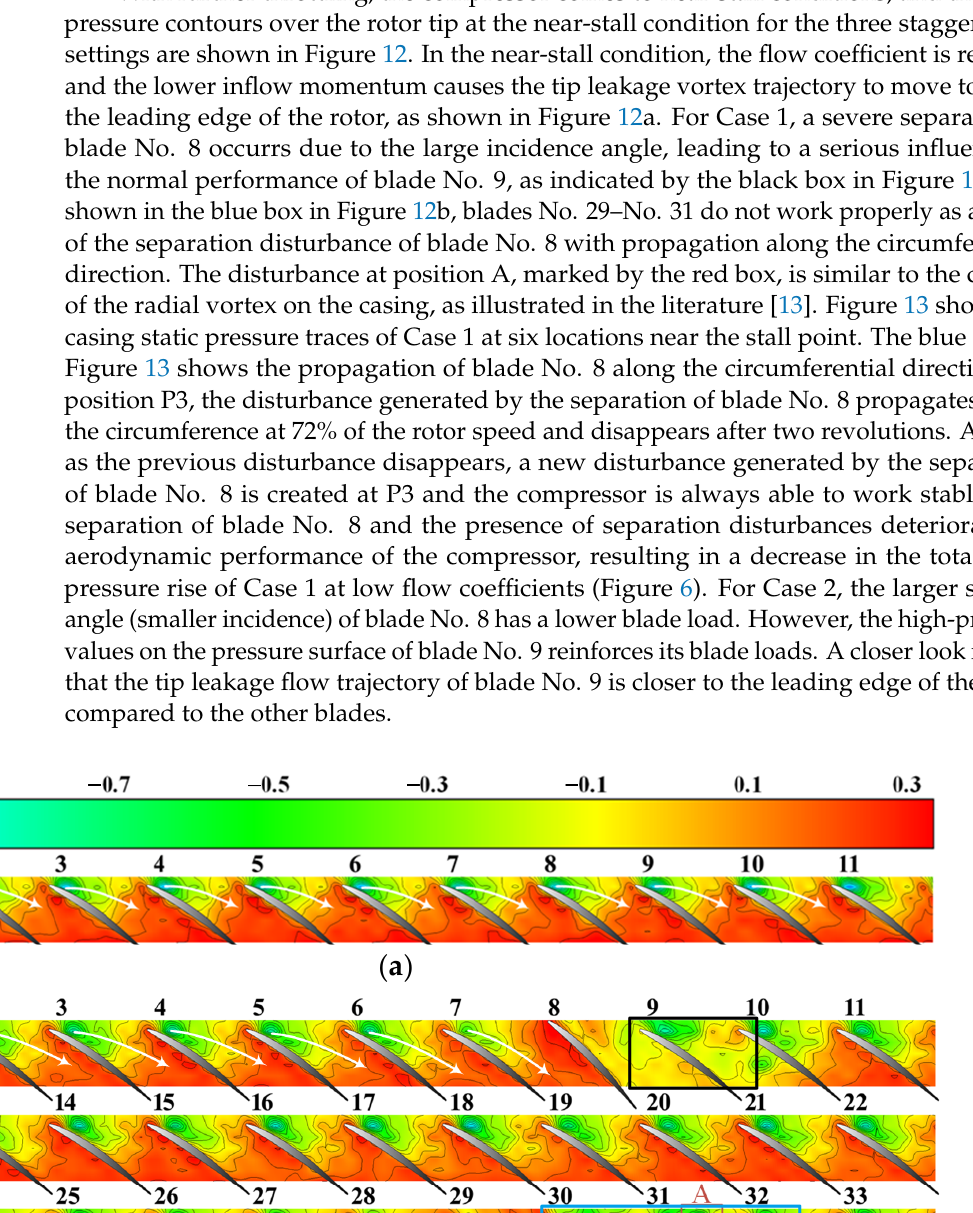
Figure 13. Casing static pressure trajectory of Case 1 at the near-stall point. Above all, the non-uniform distribution resulting from an increased or decreased lo- cal stagger angle will deteriorate the stability of the compressor. A change in the stagger angle of blade No. 8 affects the load on itself and that of the surrounding blades, which always leads to an increase in one or some blade loads. The reasons for the change in blade load surrounding blade No. 8 could be explained in terms of two aspects. On the one hand, the change in the load of blade No. 8 affects the surrounding flow field; on the other hand, the change in passage area between the blades causes a redistribution of the flow field. If the blade with the largest load is recorded as the “dangerous blade,” then the “dangerous blade” in Case 1 is blade No. 8 and the “dangerous blade” in Case 2 is blade